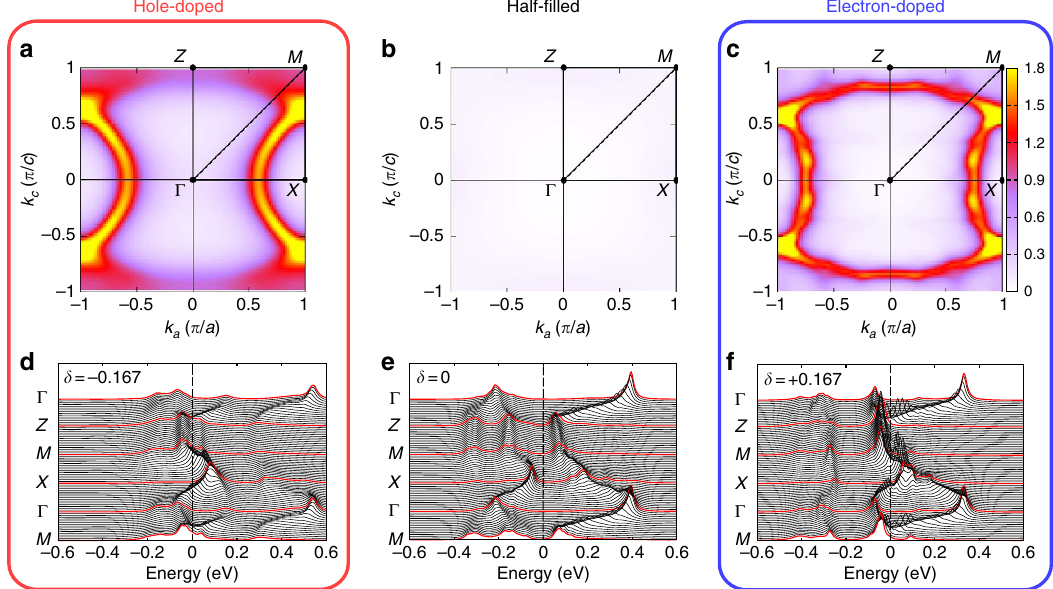
Figure 4 | Fermi surfaces and the single-particle spectral functions of the Hubbard model on an anisotropic triangular lattice at 30K. ( a – c ) Fermi surfaces in the first BZ of k -Cl for 17% hole doping ( a ), half-filling ( b ) and 17% electron doping ( c ), determined by the largest spectral intensity at the Fermi energy. ( d – f ) Single-particle spectral functions for 17% hole doping ( d ), half-filling ( e ) and 17% electron doping ( f ). The Fermi energy is located at o ¼ 0 and the parameter set of this model is t ’/ t ¼ (cid:2) 0.8, U / t ¼ 7 and t ¼